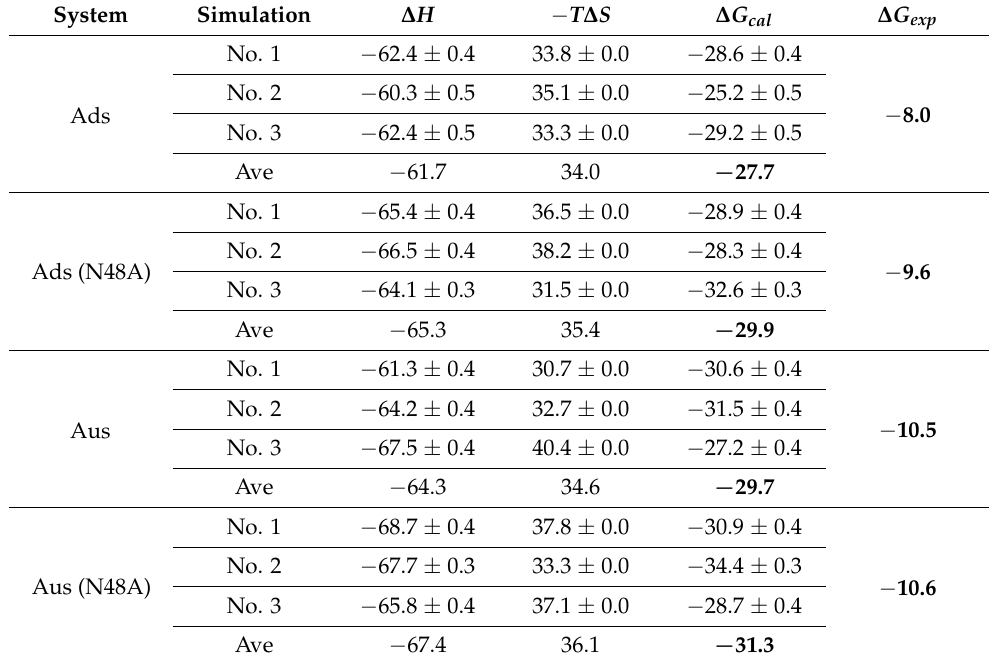
Table 1. The experimental and calculated binding free energy from three MD trajectories. The experimental values are from Shi et al. [29]. All energy values are given in kcal/mol).